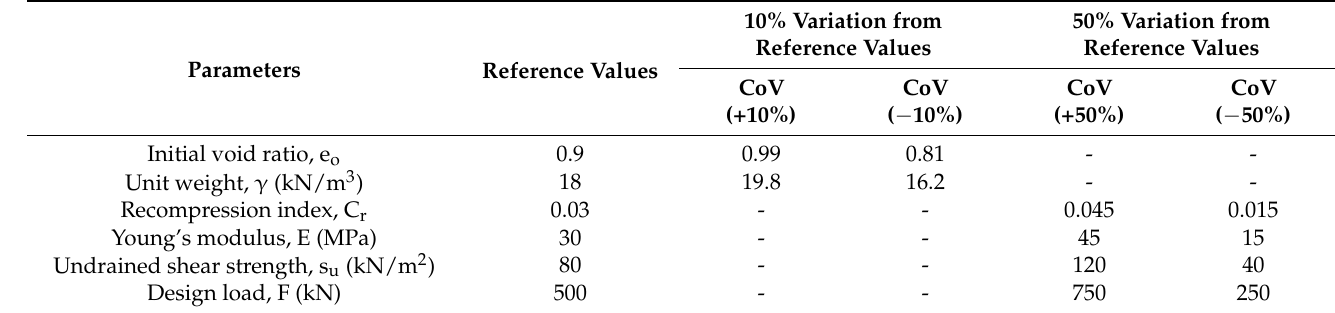
Table 4. Variation in soil properties and design